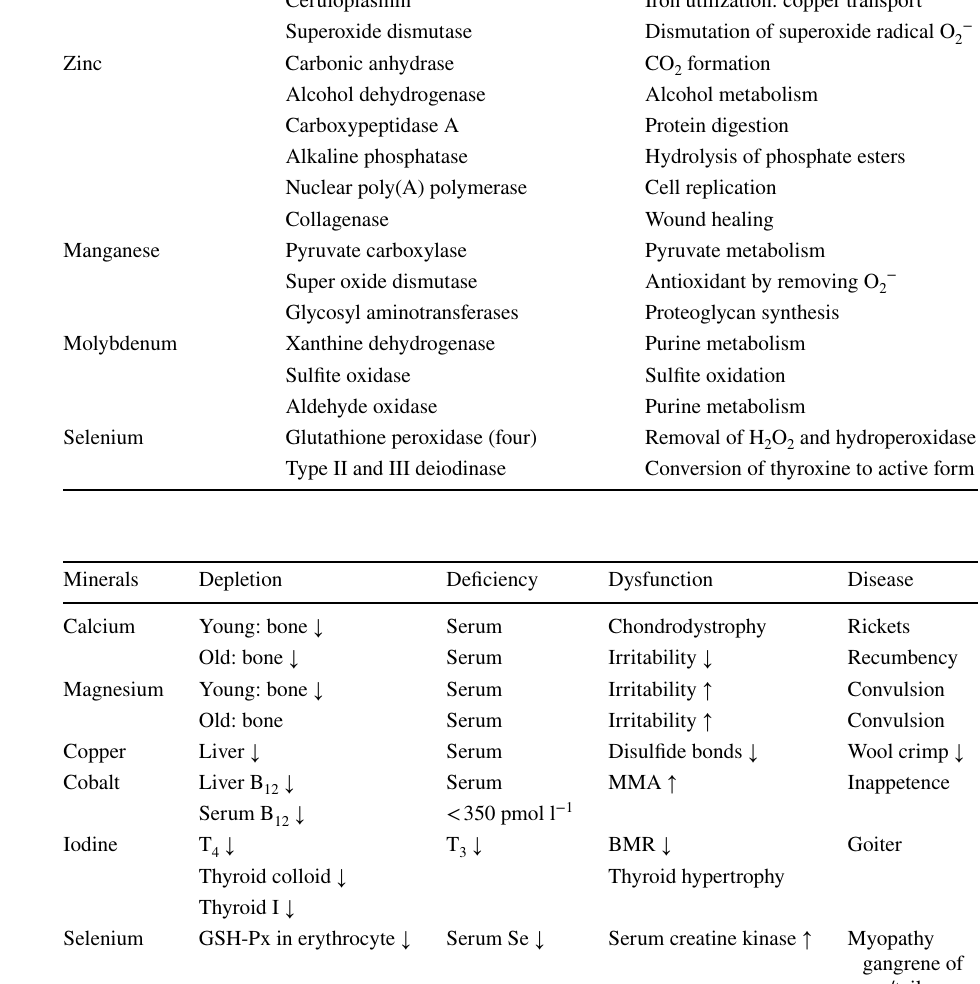
Table 7 Some important metalloenzymes in livestock (adopted from Underwood and Suttle 2001)